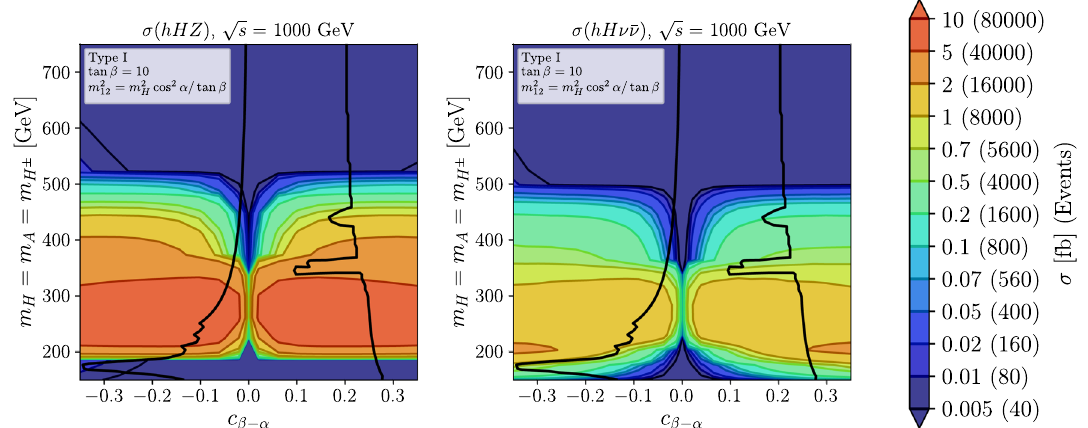
√ s = 1000 GeV for our benchmark plane 3. The total allowed